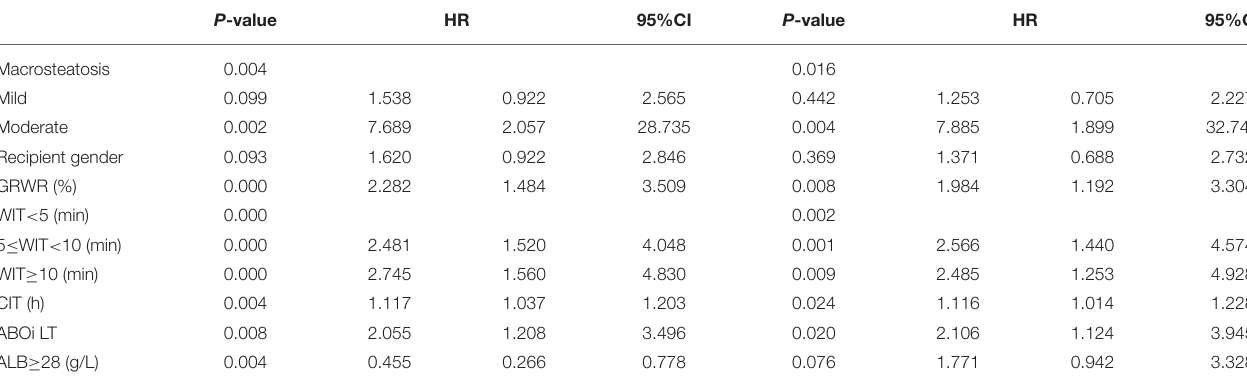
TABLE 2 | Univariate and multivariate logistic analysis of risk factors associated with early allograft dysfunction. P -value HR 95%CI P -value HR